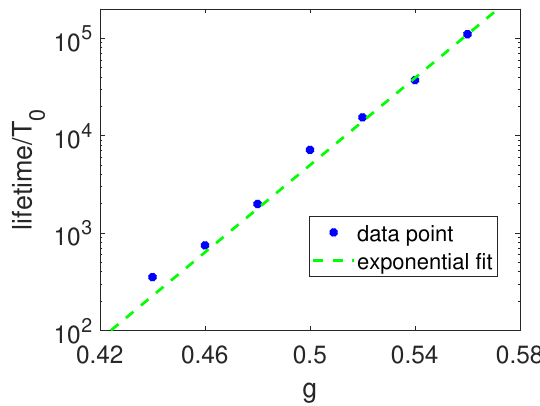
Figure 19. Dependence of the dipole CSQ lifetime on the coupling constant g . The green dashed line is the exponential fit a = 3 . 23 × 10 − 8 , b = 51 . 5 . The data points are obtained by b 0 g with a 0 e 0 0 superposing two Gaussian lumps with an oscillating frequency ω = 0 . 84 and with the same peak amplitude and width as those of an elementary Q-ball with ω = 0 . 84 and g = 0 . 5 , for more equal comparison. We vary distance d to get the maximum lifetime for a given g